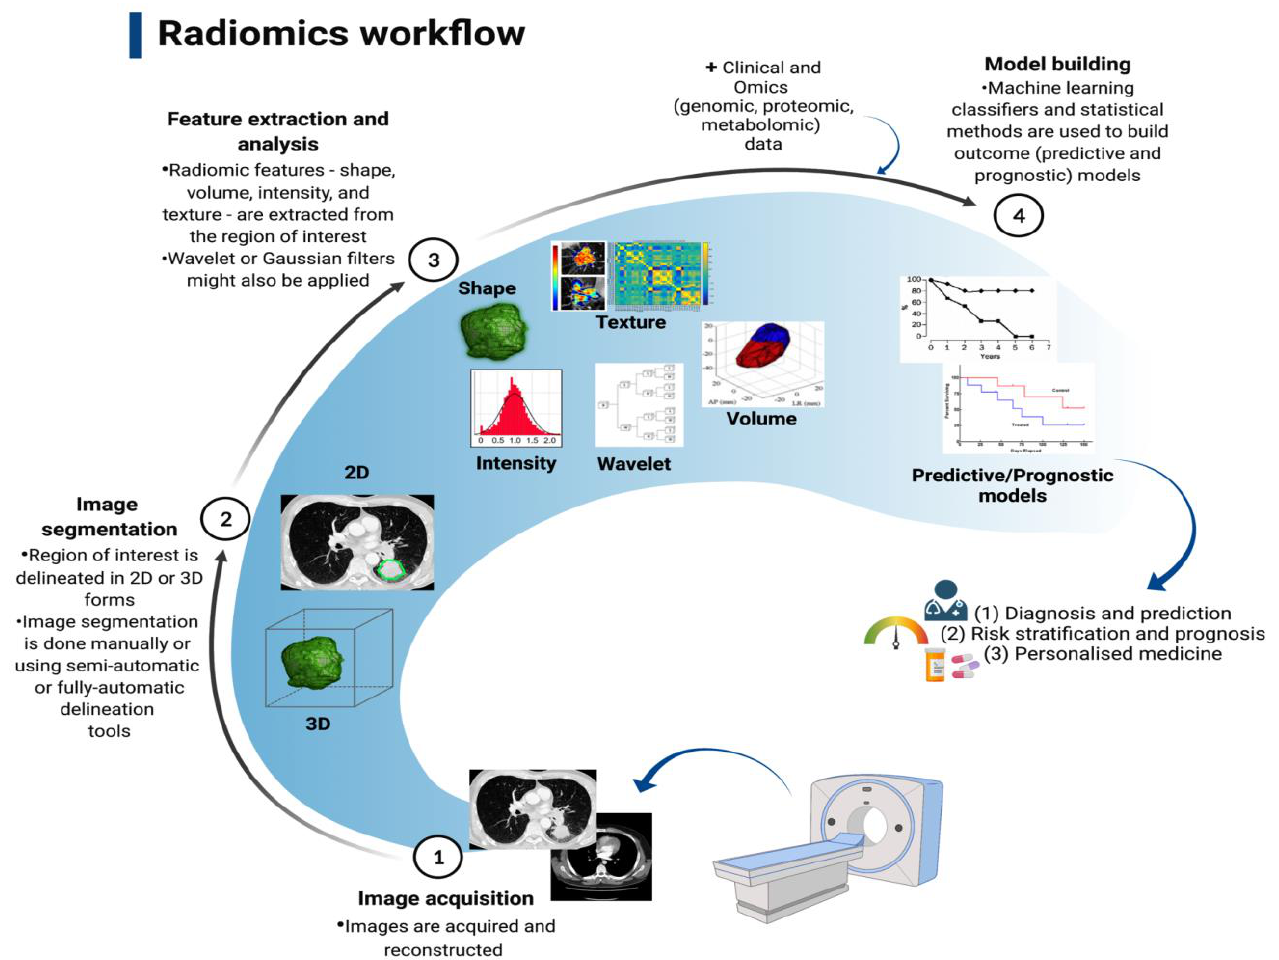
Figure 2. Radiomics workflow that involved four stages, Lambin et al. [113].